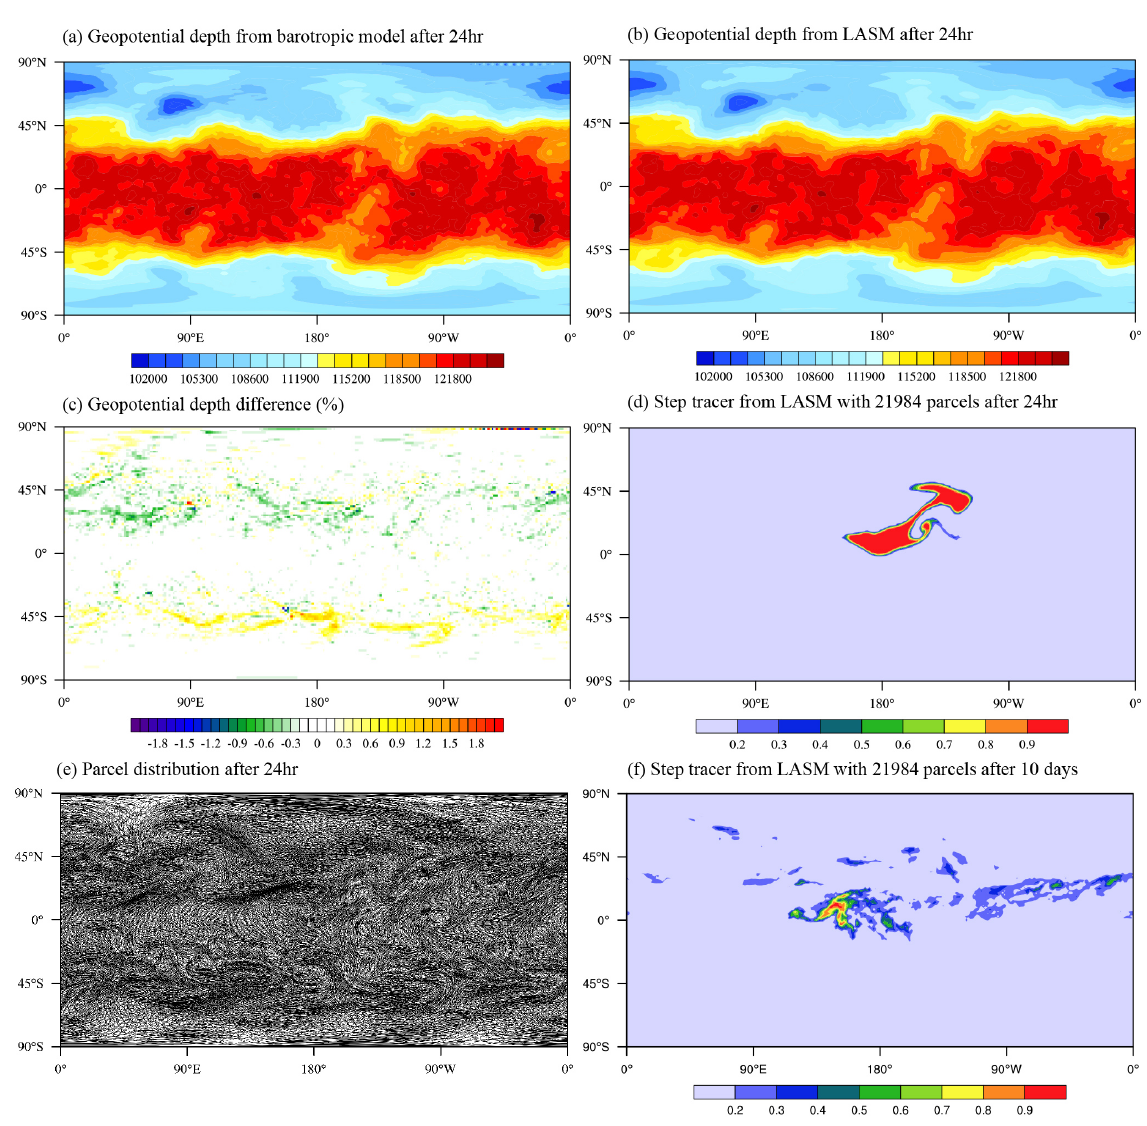
Figure 17. The simulation results after 24h in subcase